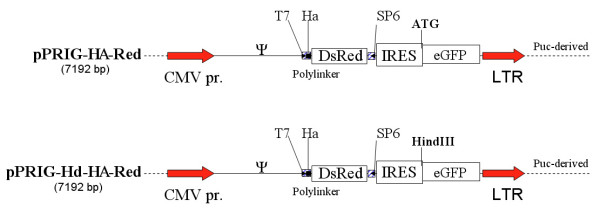
Schematic representation of the pPRIG-HA-Red and pPRIG-Hd-HA-Red retroviral vectors. Top drawing illustrates pPRIG-HA-Red, in which the coding sequence of DsRed has been cloned in the polylinker, while pPRIG-Hd-HA-Red is the same exact construct except that the IRES initiation codon is modified into a HindIII site (see Table 1). The psi letter (Ψ) is the MLV encapsidation sequence, the CMV promoter drives the expression of the bicistronic RNA, the hatched boxes flanking DsRed correspond to the polylinker, encompassing the T7 and SP6 sequences and the HA coding sequence, the IRES corresponds to the EMCV-derived IRES fragment, eGFP is the coding sequence for green fluorescent protein used to track the first cistron expression, and the LTR corresponds to the MLV long terminal repeat. The hatched line symbolizes Puc-derived plasmid backbone.